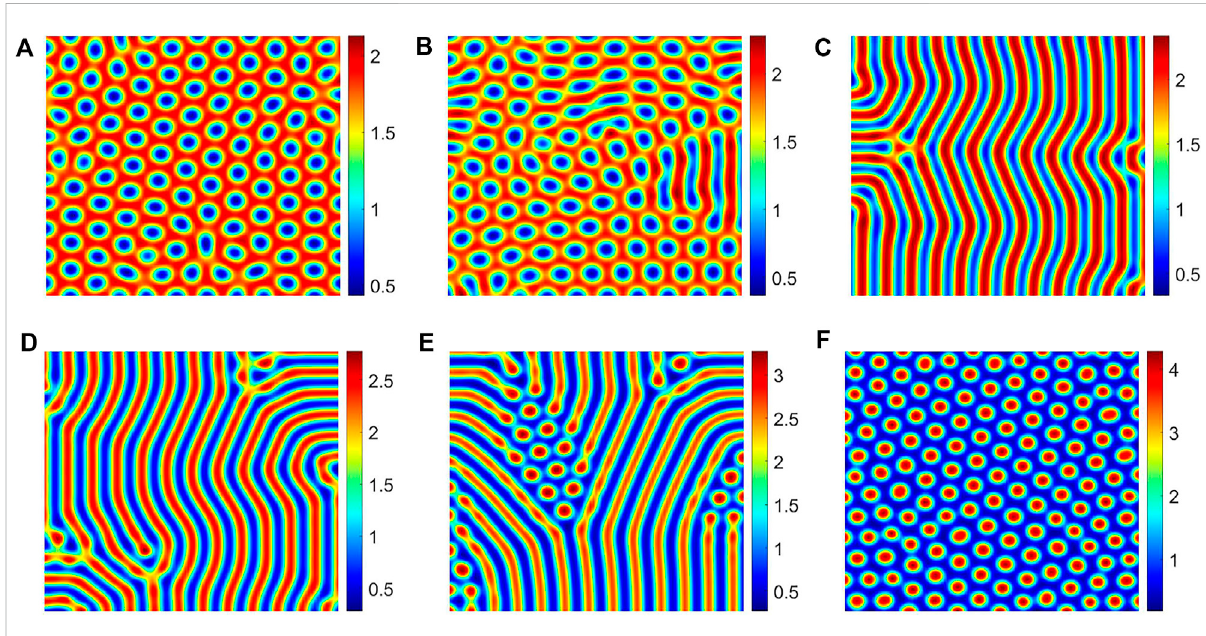
FIGURE 5 Differentvaluesoftheparameter d 2 correspondtodifferentvegetationpatterns, (A) d 2 =7.80, (B) d 2 =8.21, (C) d 2 =9.00, (D) d 2 =10.20, (E) d 2 = 12.80, and (F) d